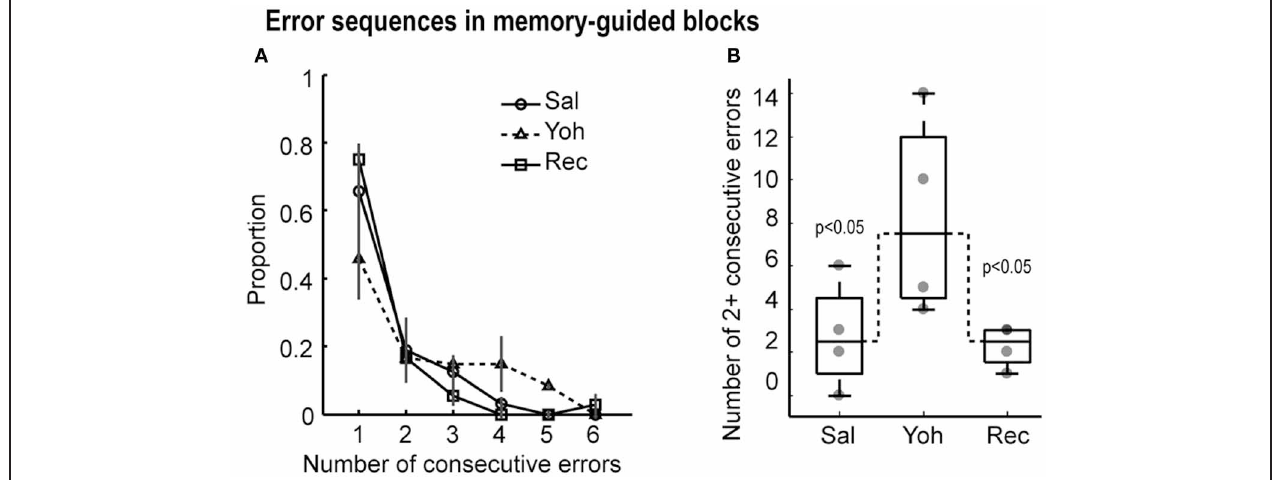
testing sessions. Gray dots depict the values for each of the four rats. Dashed lines link the median values for more than two consecutive errors, which were significantly different by Friedman’s ANOVA at p < 0 .